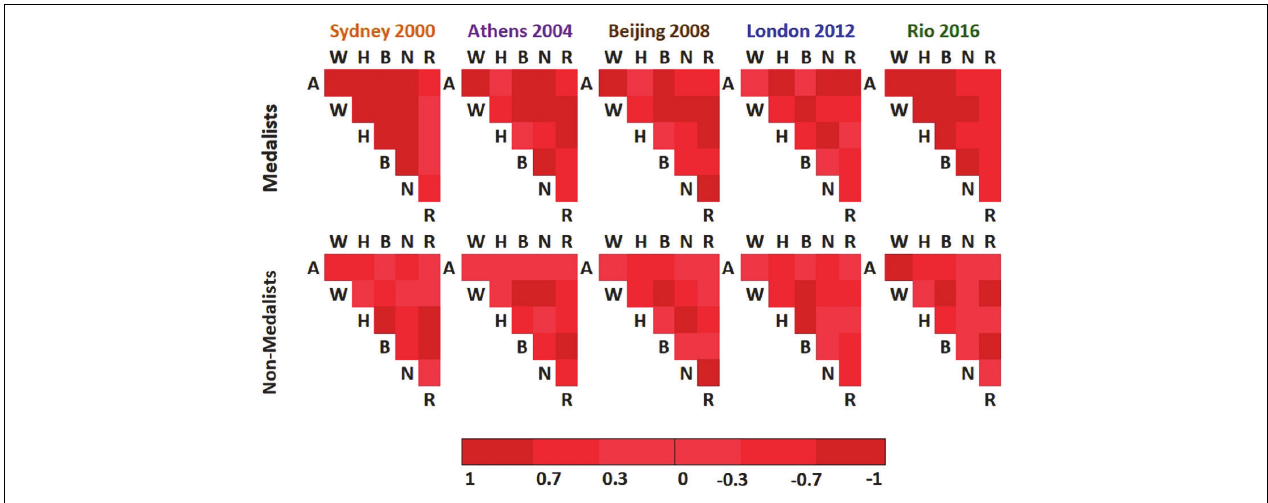
FIGURE 1 | The heat map of the Pearson’s correlations results among variables for each edition and complex network model. Predominantly, the weighted links between Medalists had highest values than the weighted links of non-medalists athletes, with significant differences between groups (One-way ANOVA followed by Tukey HSD post hoc test, p < 0.01 at 2000, 2004, and 2008 editions and p < 0.05 at 2012 and 2016 editions). In this figure, A, age; W, weight (kg); H, height (cm); B, body mass index (kg/m 2 ); N, number of Olympic medals and R, reaction time